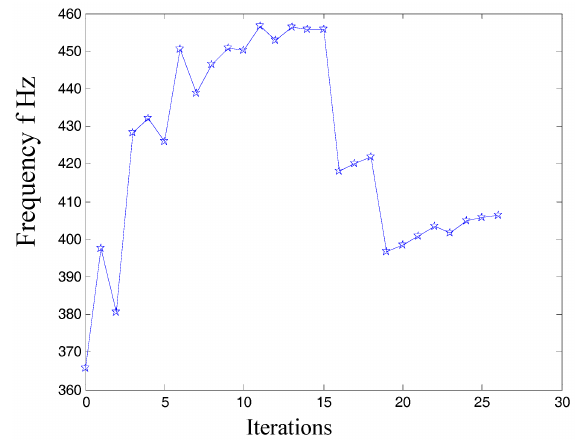
Figure 12. The objective function iteration of dynamics topological optimization results.